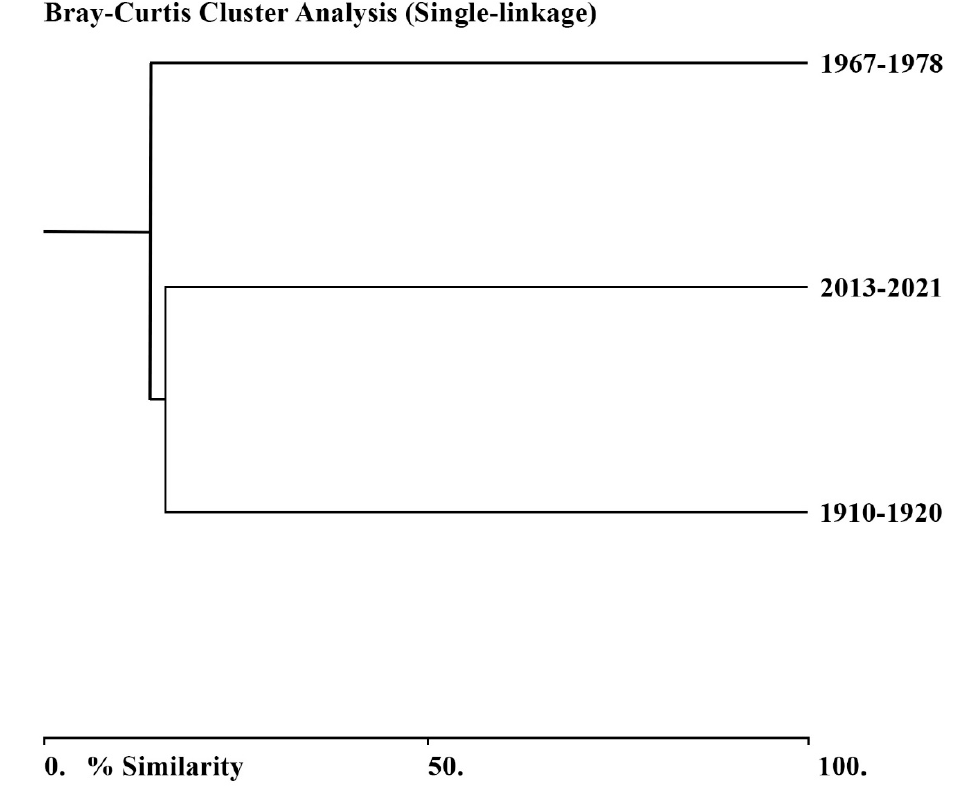
Figure 3. Bray-Curtis tree of species composition comparison in three periods of the Nesamovyte Lake study (1910–1920; 1967–1978; 2013–2021).